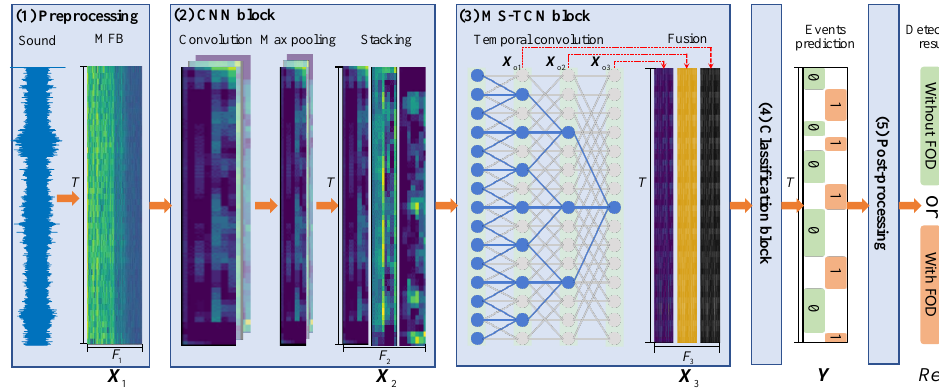
Figure 2. The MS-CTCN-based FOD detection